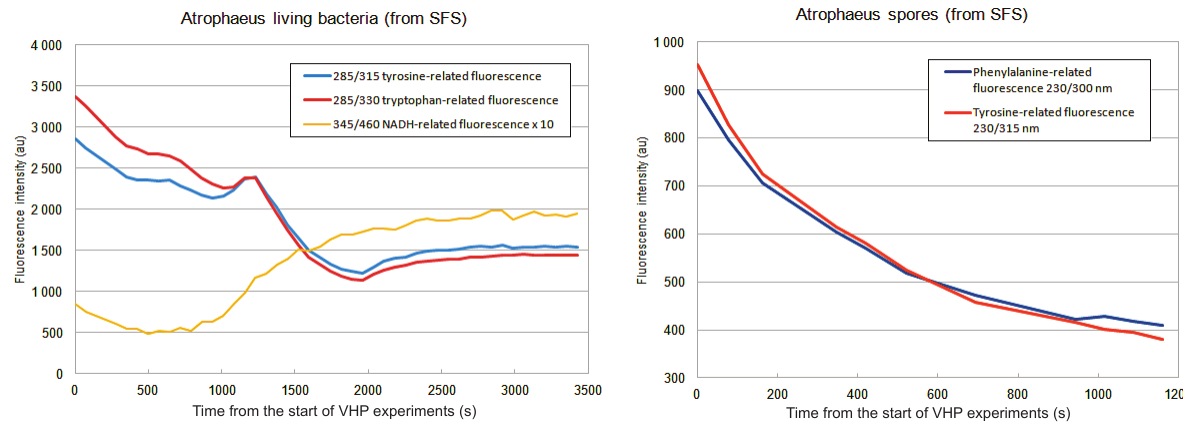
Fig. 6. Left graph – comparison of intensities of tryptophan fluorescence (red line) and more tyrosine-like fluorescence (blue line) as a function of time during VHP exposure (in seconds). The yellow line represents the 345 nm/460 nm signal that is associated with the “NADH-like” fluorescence region, much of which can be attributed to oxidation induced fluorescence [10,11]. The VHP concentration was ~500 ppm. A clear activity similar to conformational change is revealed at ~1250 seconds, where one can assume that denaturation of important proteins is taking place. Right graph – in the spores of the same bacteria, one can see the longer- wavelength tyrosine-tryptophan peak’s emission also fall at a faster rate compared to phenylalanine-tyrosine, indicating similar energy-transfer disruption processes during the VHP